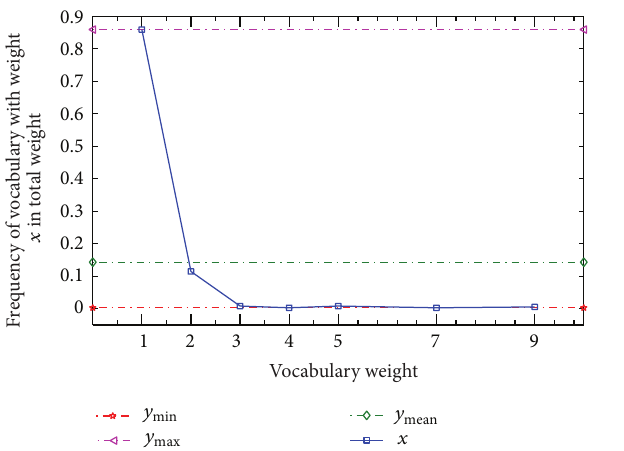
Figure 6: Relationship between vocabulary weight and frequency of vocabulary.